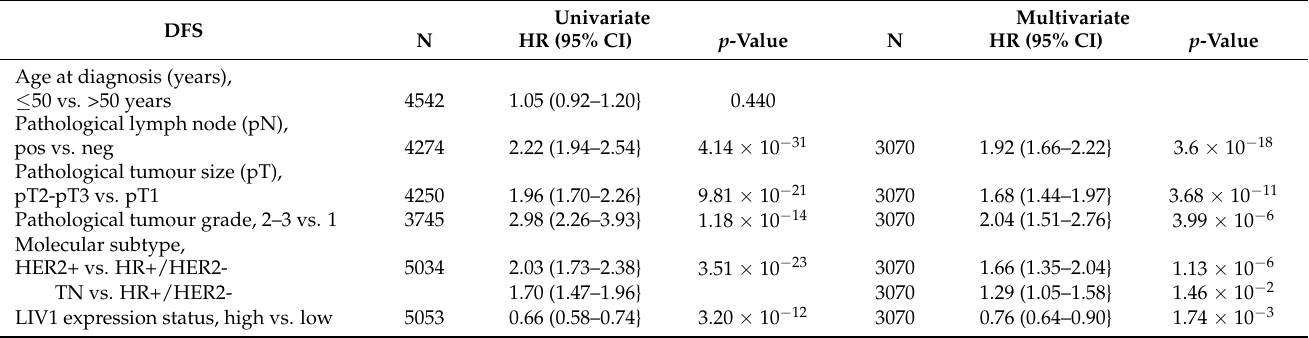
indicates the statistical level.